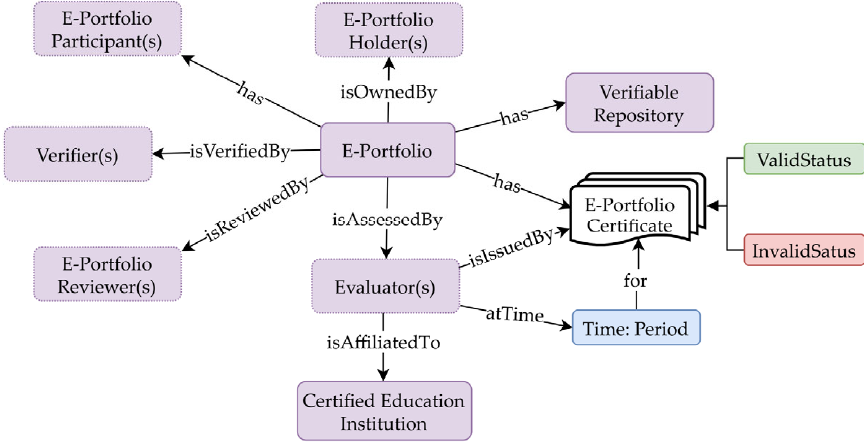
Figure 1. Definition of e ‐ portfolio concepts using ontology representation.